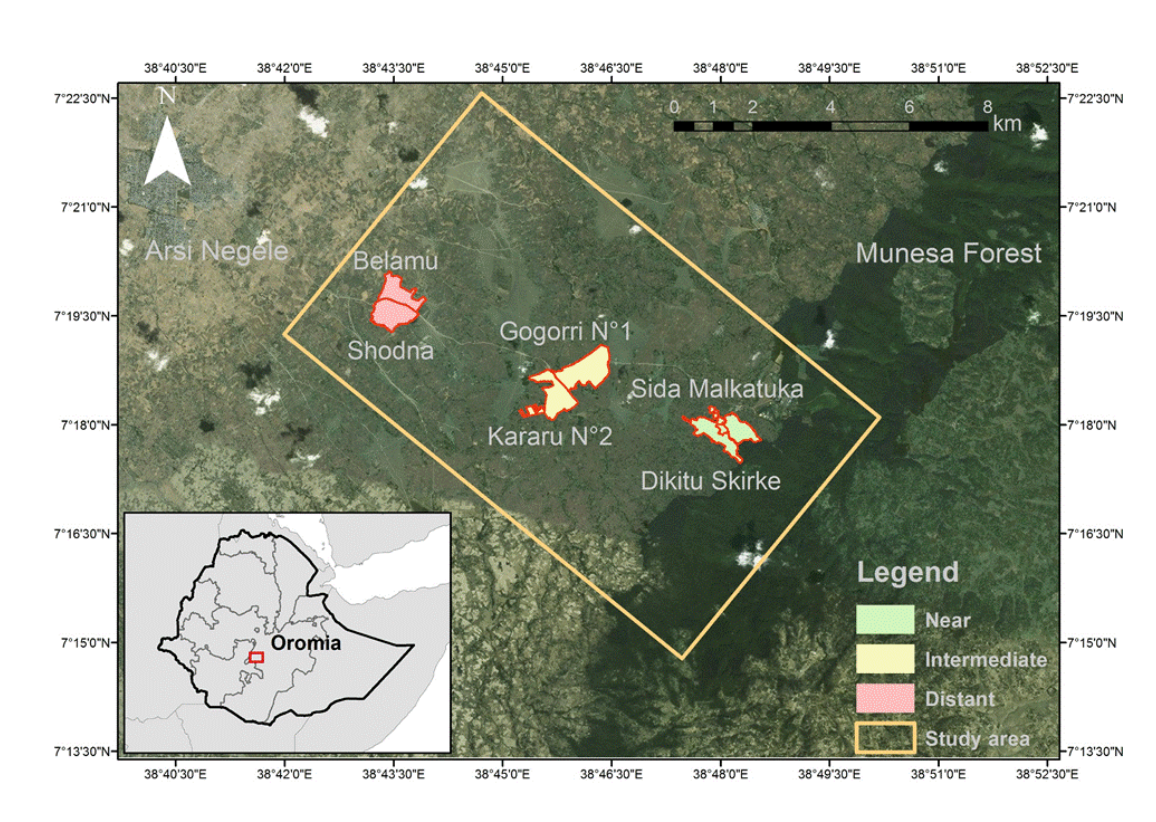
Fig. 1 . Map of the study